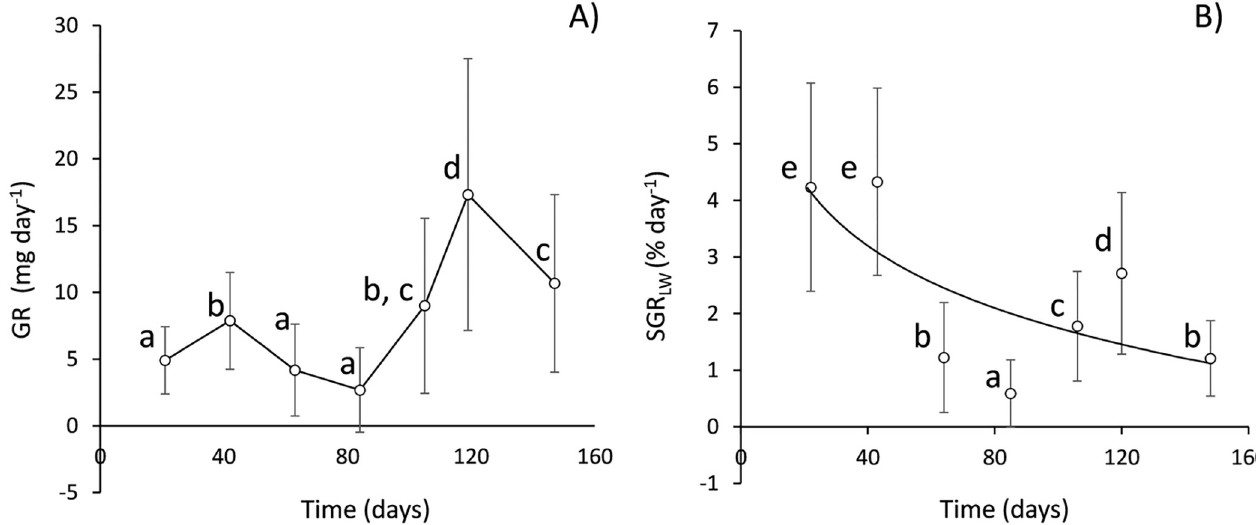
Fig 2. Mean rates of daily growth along the period of study, given in both A) absolute terms (GR: mg LW day -1 ) and B) relative weight specific terms (SGR: % day -1 ). Error bars represent ± SE. For reference, an exponential function was fitted to all individual data for SGR vs time (line in B): SGR = 3.621 ( ± 2.189) � e (-0.008 ± 0.006) � Time . Results of post-hoc test following ANOVA: Different letters denotate significant mean differences.